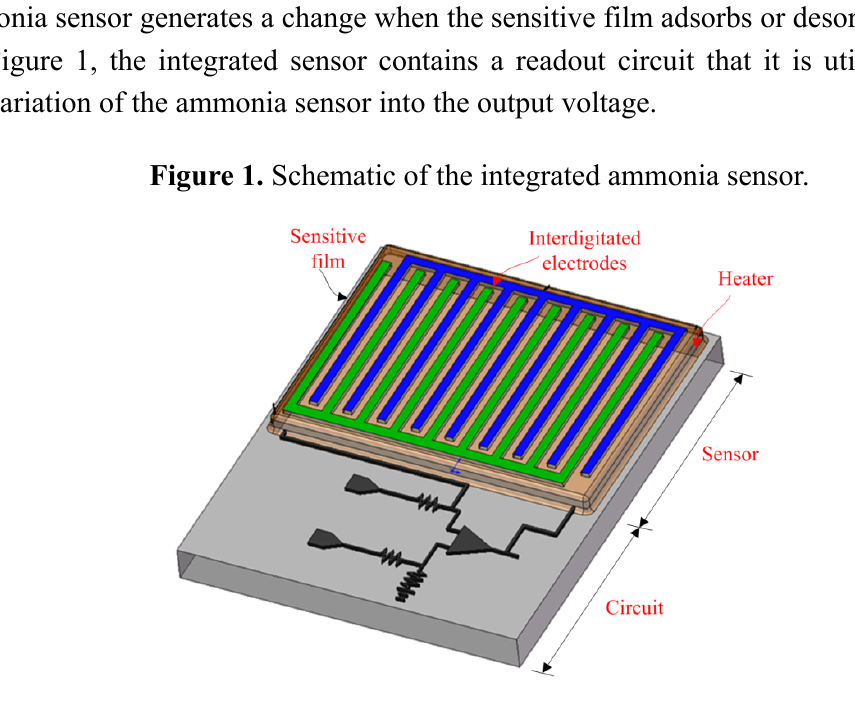
Figure 2. The readout circuit for the ammonia